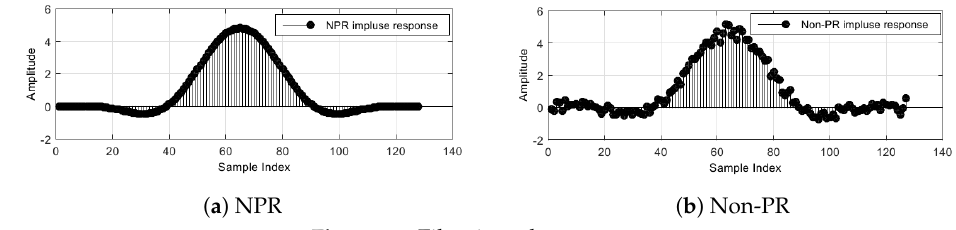
Figure 21. Filter impulse